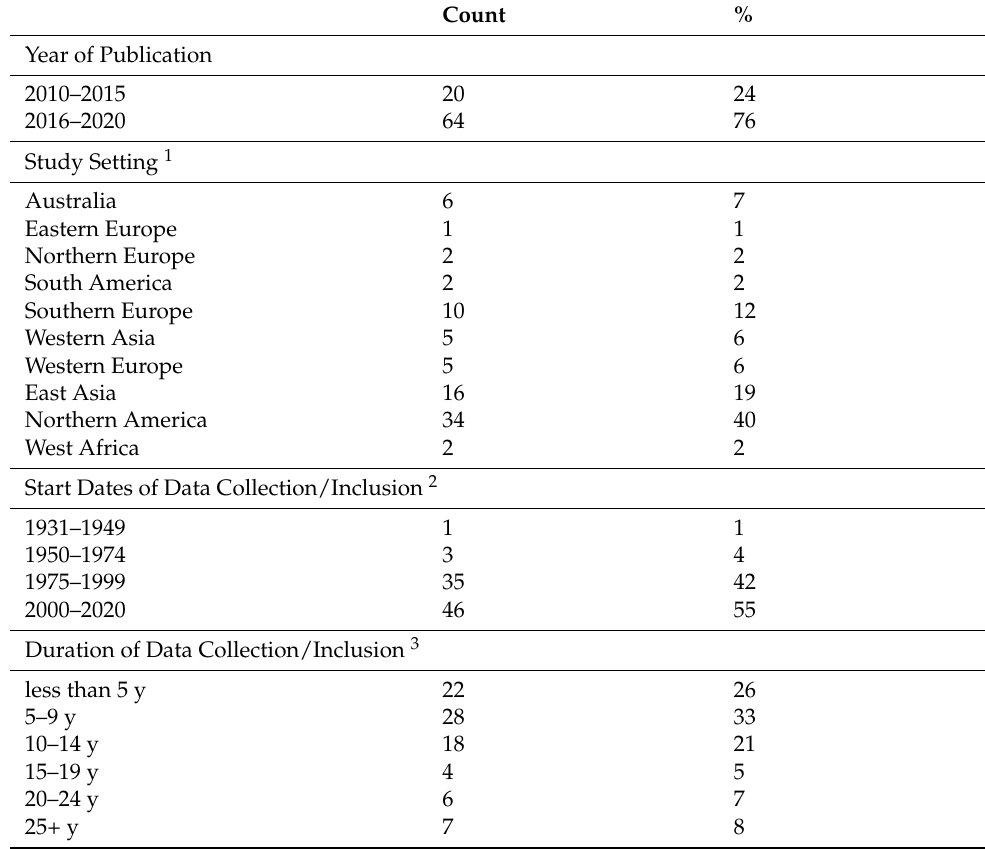
Table 1. Study characteristics n =